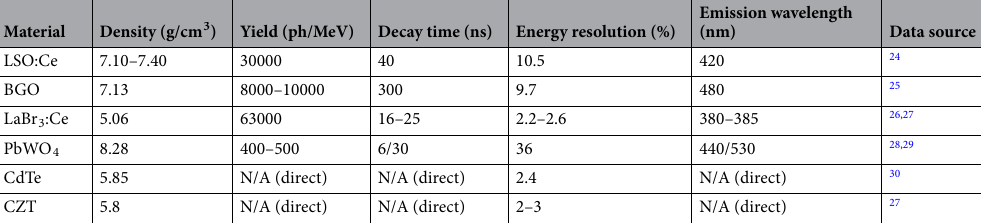
Table 2. Detector materials, including a range of scintillators and two direct-detection